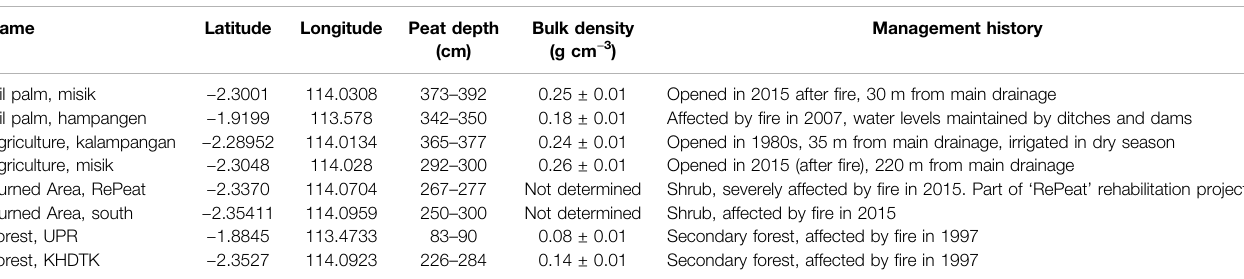
TABLE 1 | Locations, properties and management histories of Central Kalimantan study